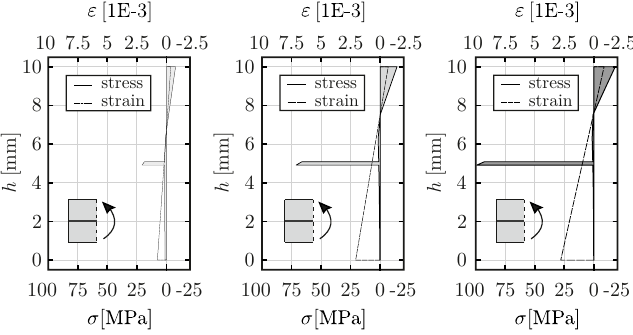
Figure 15. Development of strain and strain profiles of the carbon concrete beam with cross section (ii) according to Figure 14.